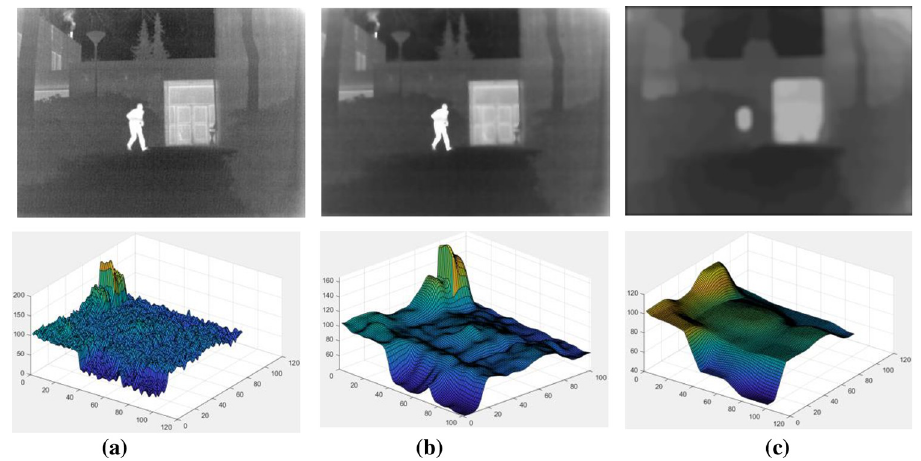
Fig 3. A surf plot of the proposed clustering algorithm versus ADF clustering results. The first row includes, from left to right: infrared image, ADF clustering results, and the proposed algorithm clustering results; the second row includes, from left to right: infrared image partial area surf map, ADF clustering partial area surf map, and the proposed clustering algorithm partial area surf map. The abscissa of the Surf map represents the spatial position of the pixel, and the ordinate represents the size of the pixel